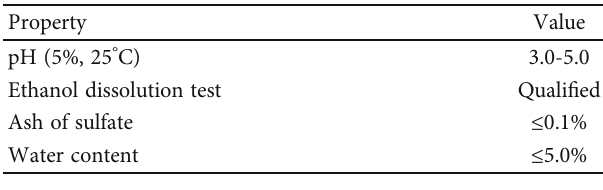
Table 3: Properties of surfactant.